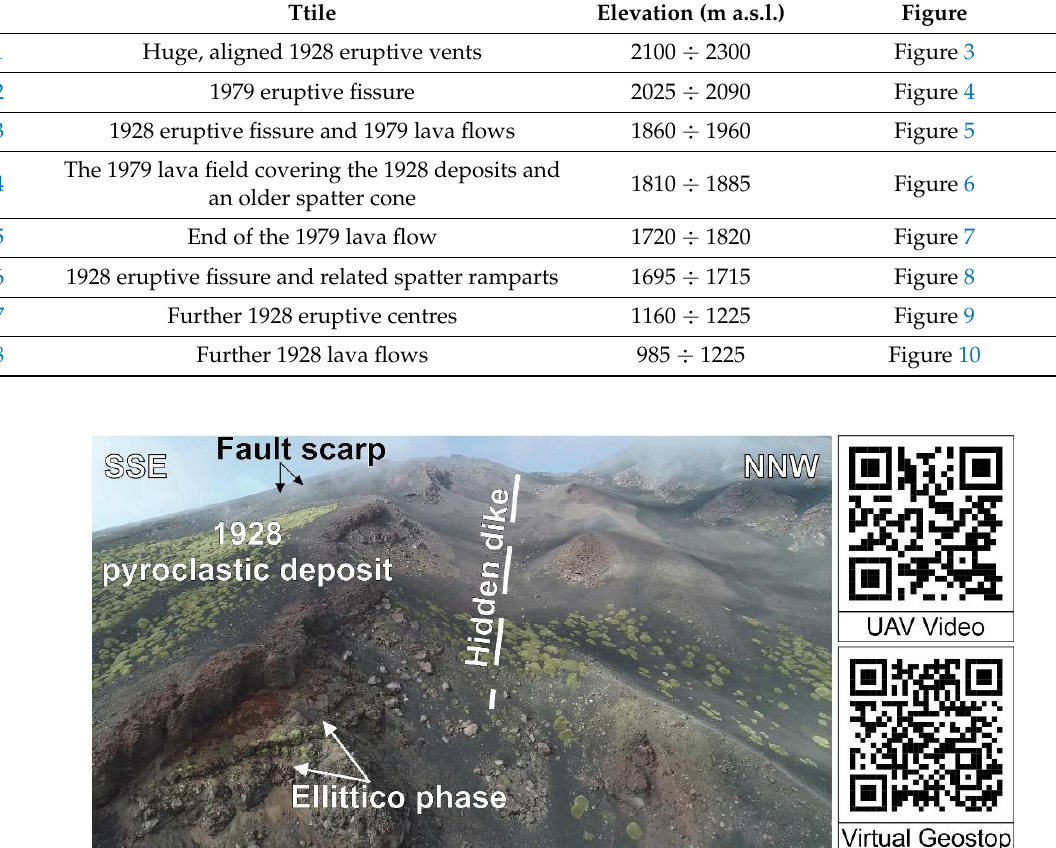
Figure 3. The image on the left shows geostop 1 through a WSW-looking UAV-captured picture. The QR codes on the right enable opening the corresponding UAV-captured video and the related VG. By using a mobile phone or a tablet, open up the QR code reader. Hold your device over the QR code, so that it is clearly visible on your screen. Press the notification and wait a few seconds.